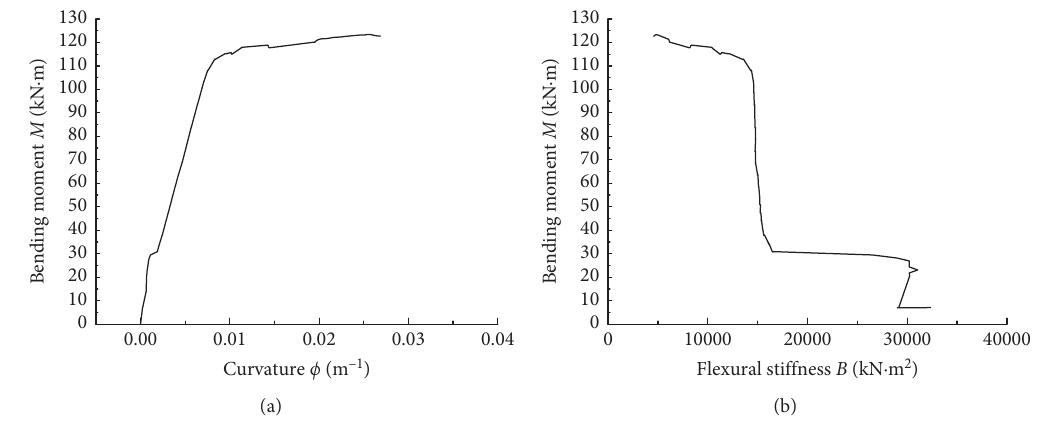
Figure 10: B-1-30-8. (a) Bending moment-curvature curve. (b) Bending moment-stiffness